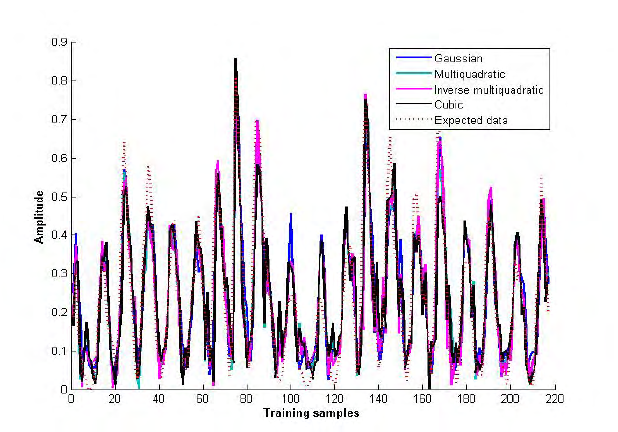
Fig. 11. Testing the individual NARX-RBFNNs - sunspot